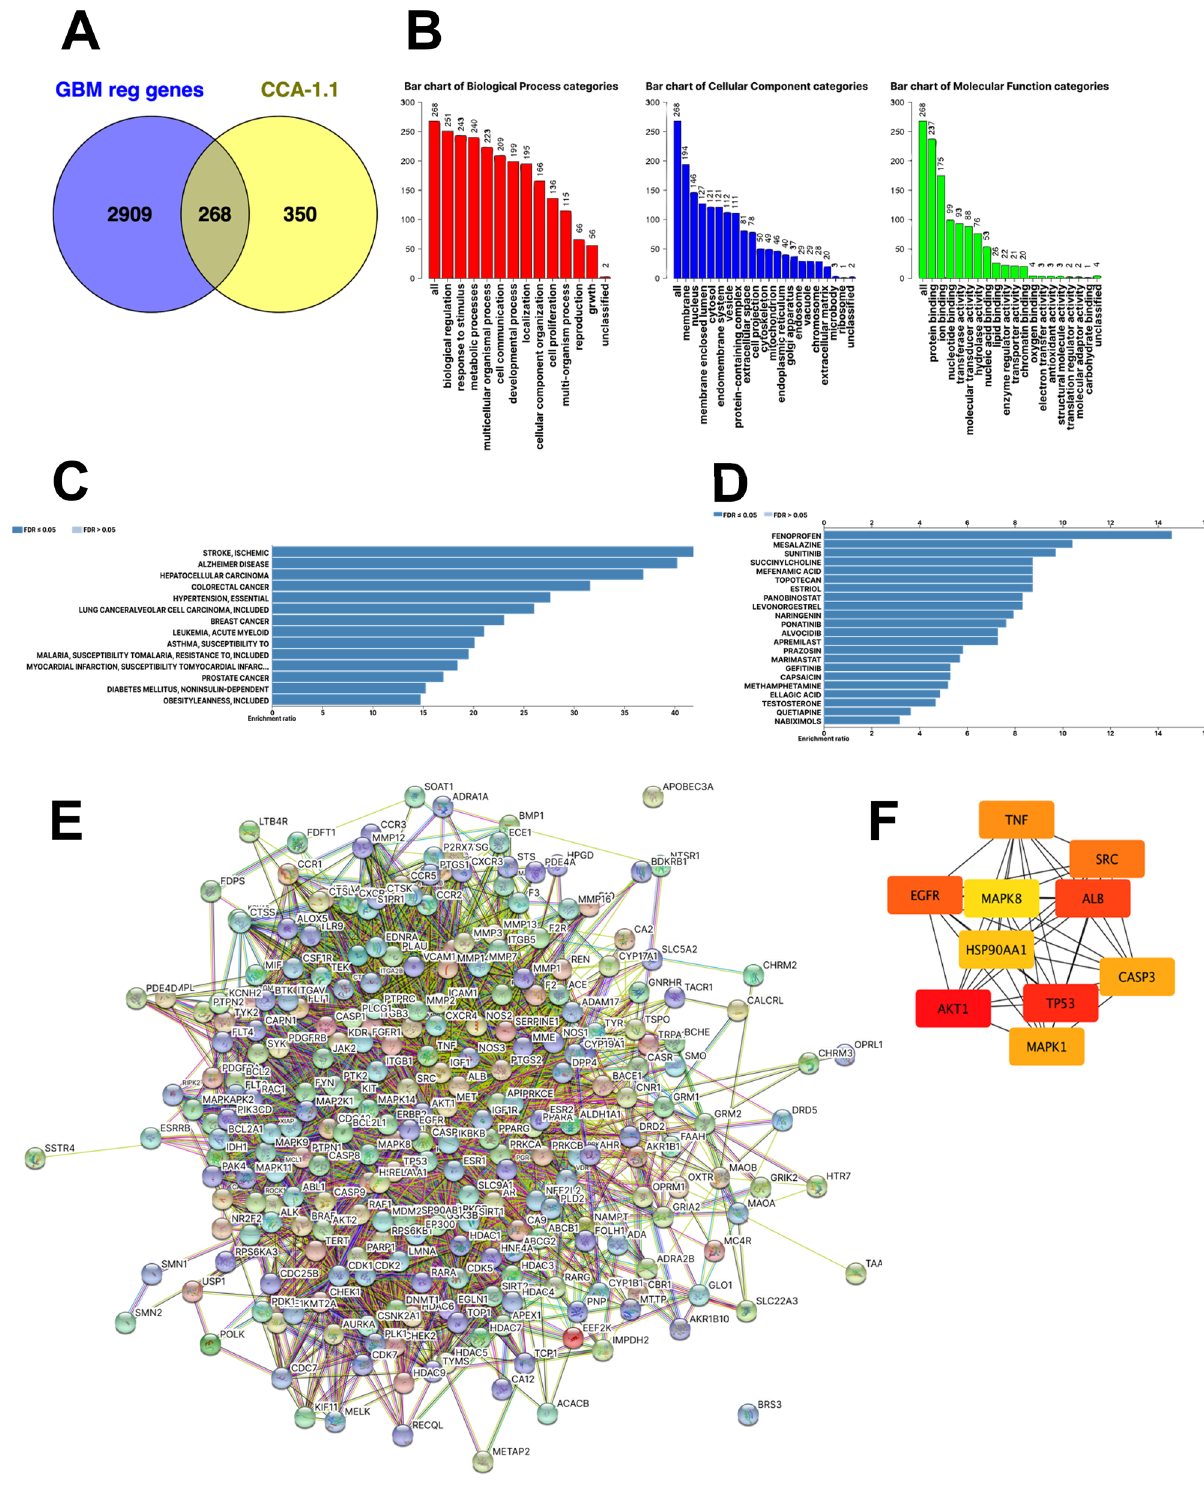
Figure 3. ( A ) Venn diagram showing 268 potential targets of CCA-1.1 against GBM (PTCG). ( B ) Gene Ontology enrichment analysis of the PTCGs. ( C ) Disease–gene association analysis of the PTCGs. ( D ) Drug– gene association analysis of the PTCGs. ( E ) Protein–protein interaction network of the PTCGs. ( F ) Top 10 protein in the network, ranked by degree, as analyzed by